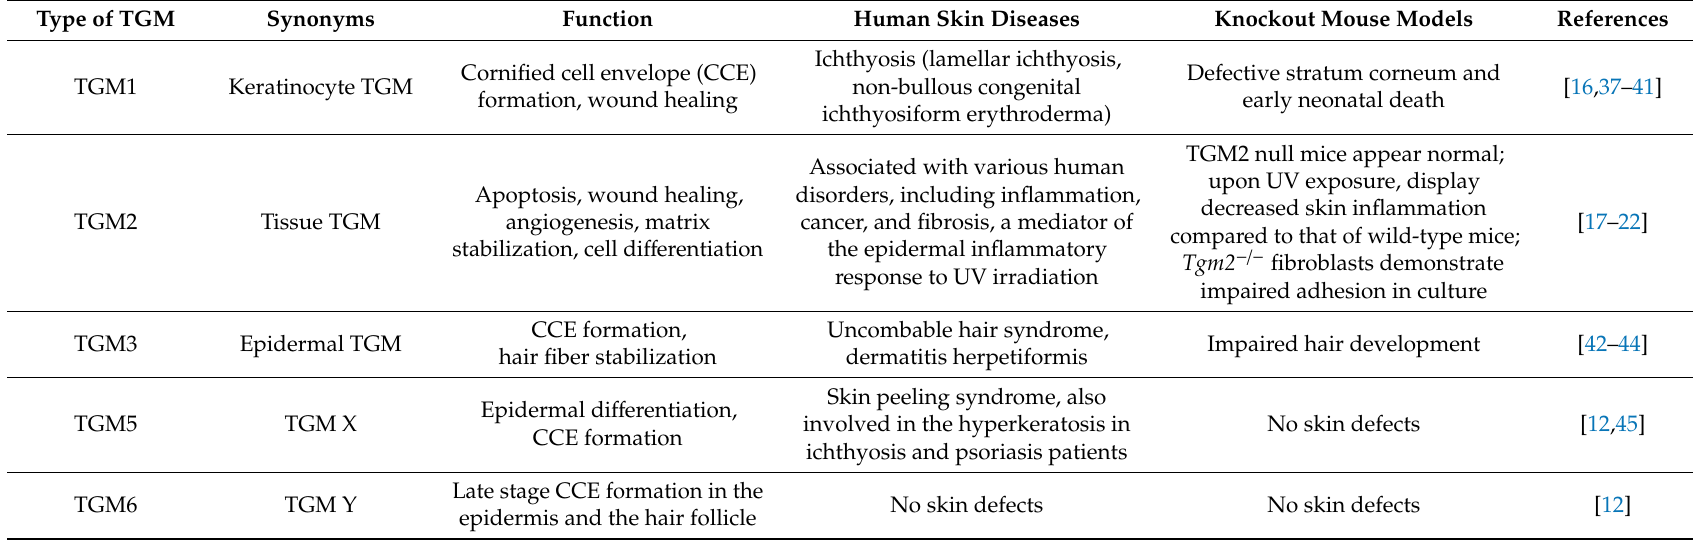
Table 1. Skin-related